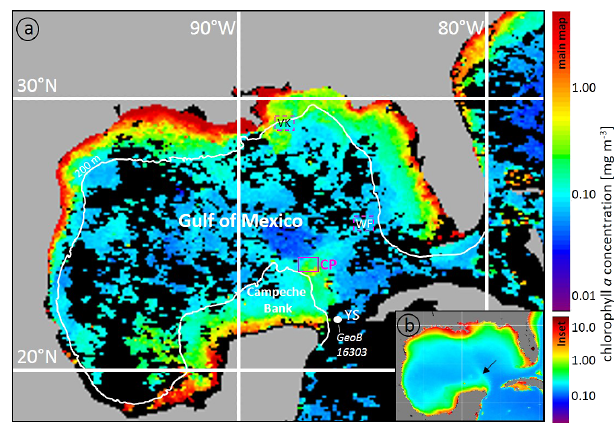
Fig. 1. SEAWIFS satellite ocean color data transferred into chlorophyll a concentrations for the Gulf of Mexico (source: http://oceancolor.gsfc.nasa.gov). (a) The map refers to an 8-day composite representing the period 22–29 September 2010. Black indicates data gaps. The Campeche cold-water coral province (CP) is influenced by increased productivity probably forced by local up- welling at the northeastern rim of the Campeche Bank (Molinari and Morrison, 1988). The white dot in the Yucatan Strait (YS) indi- cates CTD station GeoB 16303-1. The white line marks the 200m isobath within the Gulf of Mexico. VK: Viosca Knoll cold-water coral setting (e.g., Brooke and Schroeder, 2007); WF: west Florida cold-water coral mounds (Newton et al., 1987). (b) The inset shows the same data as a composite for the entire SEAWIFS mission (4 September 1997 to 30 November 2010). The black arrow indi- cates the area of the Campeche cold-water coral province that is located in a region marked by a long-term enhanced